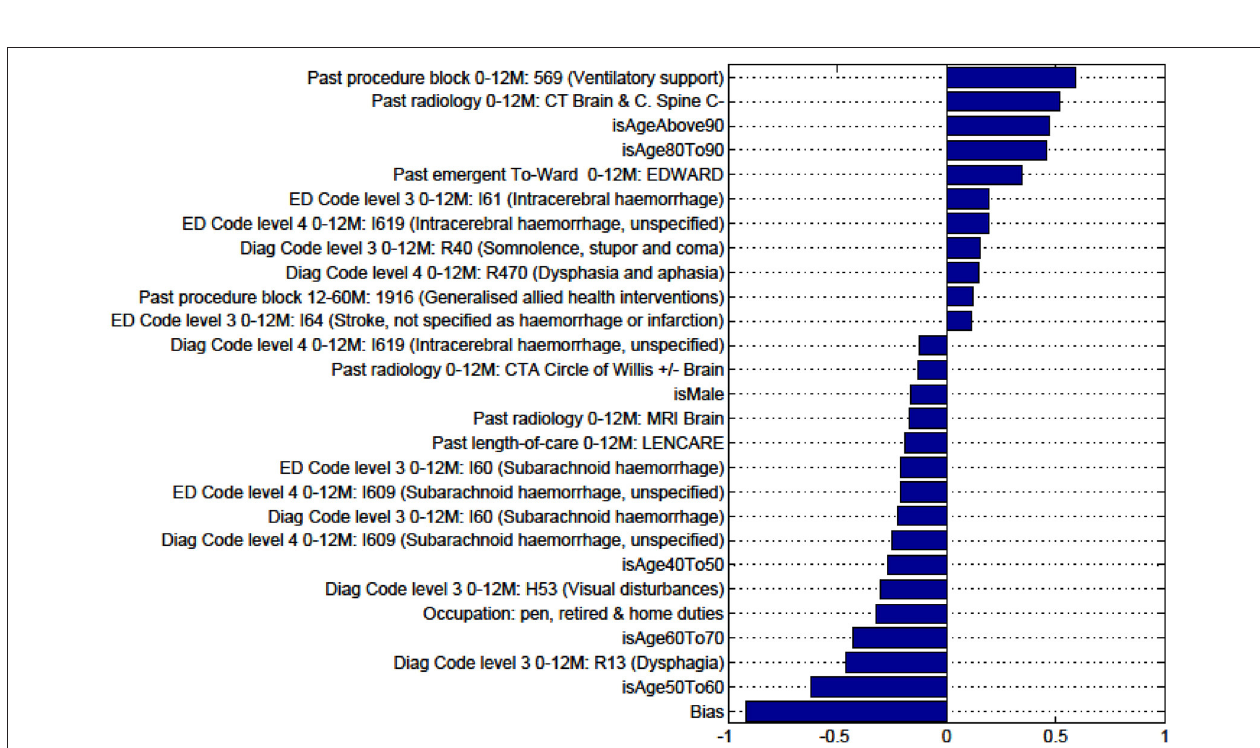
FIGURE A4 | Factors for prediction of Death vs all Other discharge destinations for the sub-cohort of intracerebral hemorrhage stroke patients.